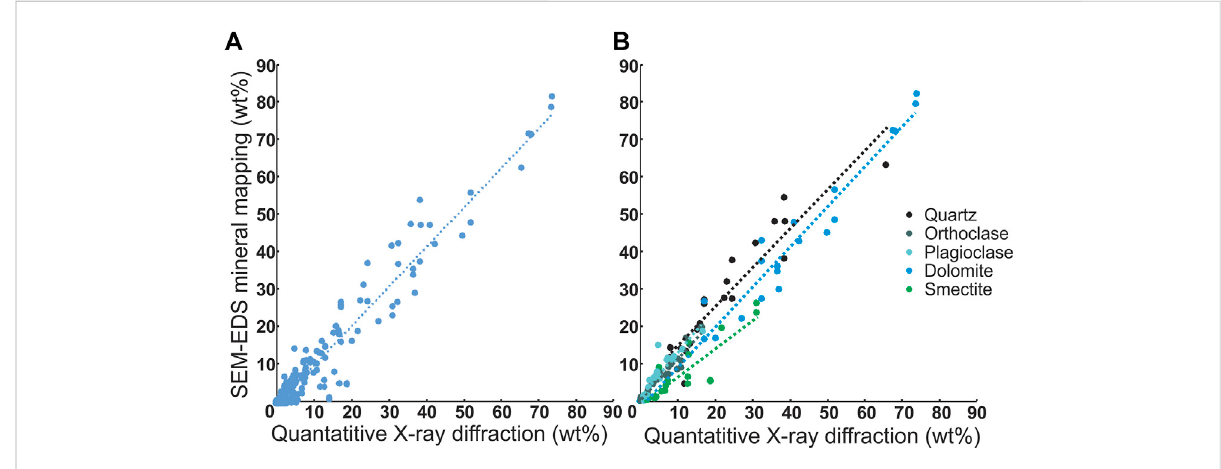
FIGURE 5 Comparison ofXRD versusSEM-EDSmineralmapping(onemineralperpixelmode)shows signi fi cantlyincreasedscatter awayfromthe1:1line comparedtothethreemineralsper “ mixel ” mode,andslopesforindividualmineralsthataresigni fi cantlydifferentto1. (A) Alldatapoints,N=220; (B) Data points of fi ve major minerals (average wt% > 5%) N = 100.